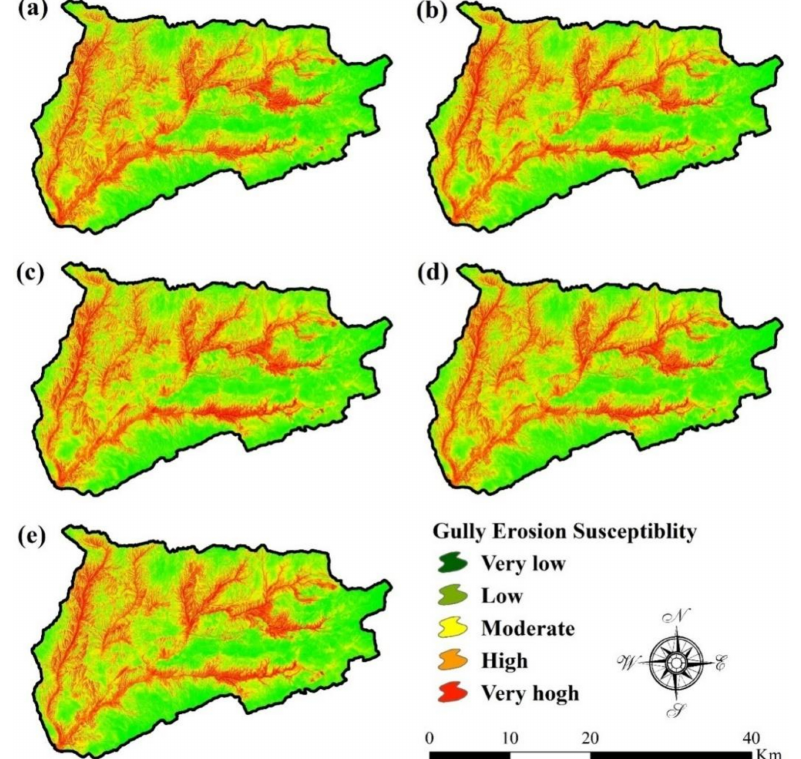
Figure 8. Gully erosion susceptibility mapping using the SVM model: ( a ) 50 / 50, ( b ) 60 / 40, ( c ) 70 / 30,